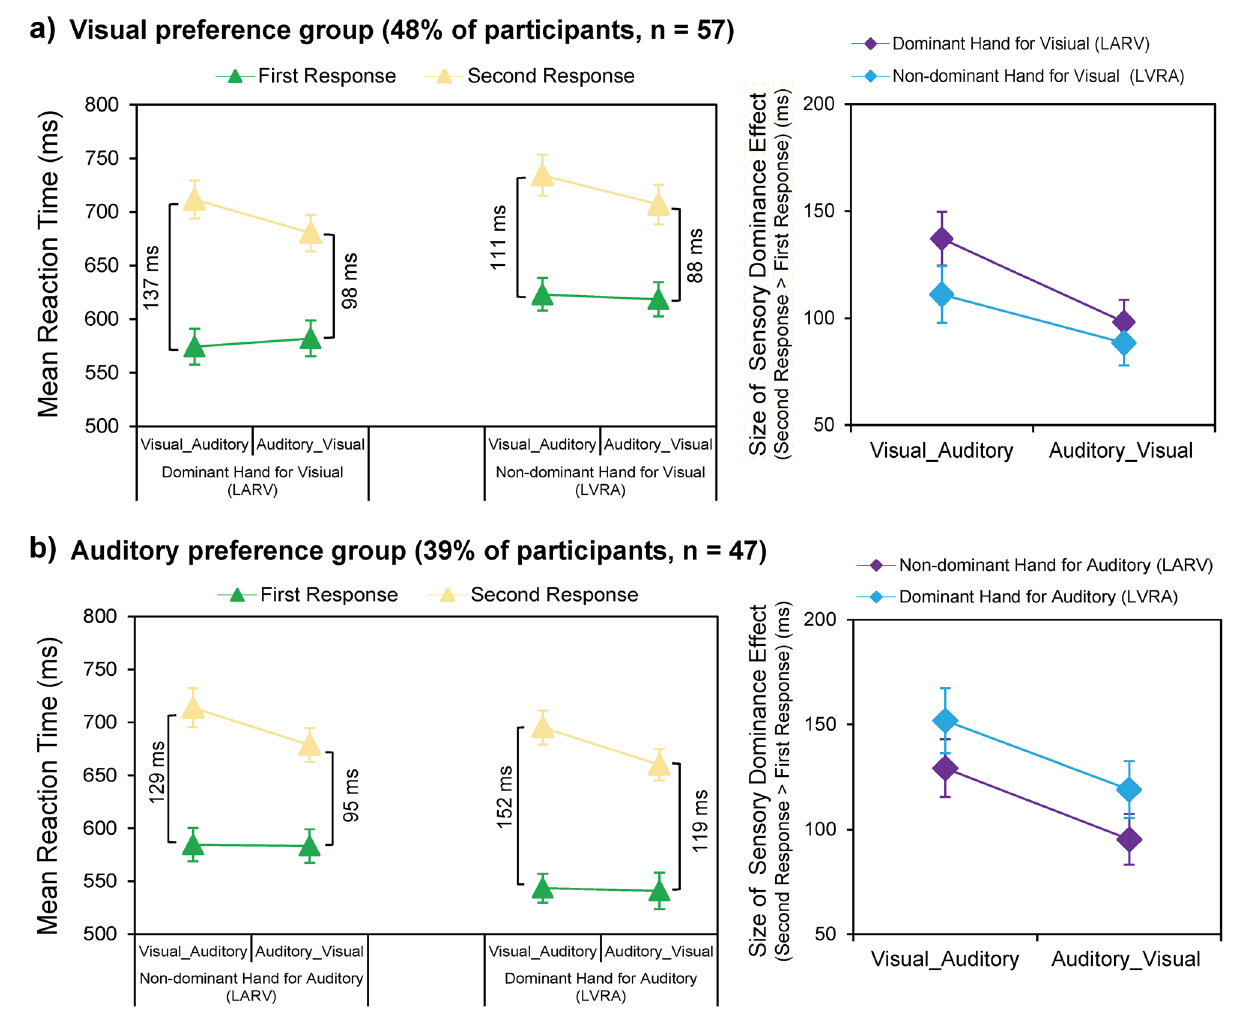
Figure 4. Interaction between the hand-modality preference and the sensory dominance for the visual preference group ( a ) and the auditory preference group ( b ). Left panel, Bimodal RTs are shown as a function of the sensory dominance (VA vs. AV trials) and the response order (first vs. second response) for the LARV (left part) and the LVRA (right part) task. Right panel, The simple effects for the significant sensory dominance*response order interaction. The sizes of the sensory dominance effects for the VA (RTa > RTv) and AV (RTv > RTa) trials are shown as a function of hand-modality assignment (LARV vs. LVRA). The error bars show standard errors